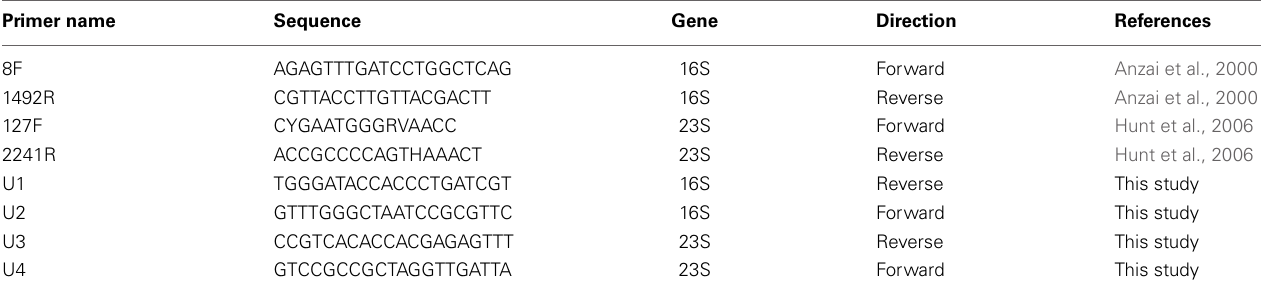
Table 1 | Universal 16S and 23S primers for rapid rRNA operon gap sequencing.